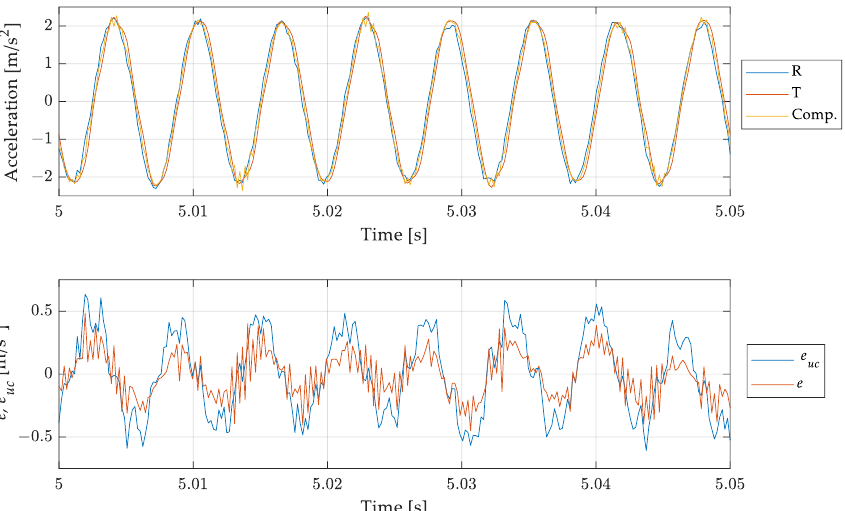
Figure 14. Test case 1, sinusoidal signal at 160 Hz: comparison of the measurand with the (uncompensated) scaled instrument indication and the compensated measurement result. Short time histories ( top ) and errors for uncompensated e uc and compensated result e ( bottom ).